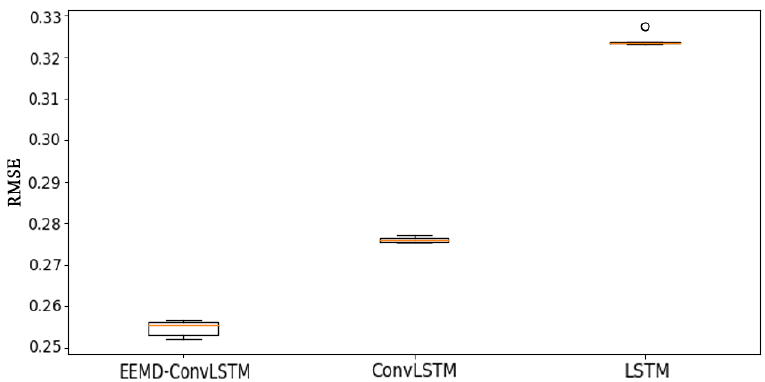
Figure 7. The box-plot of prediction results of RMSE with different